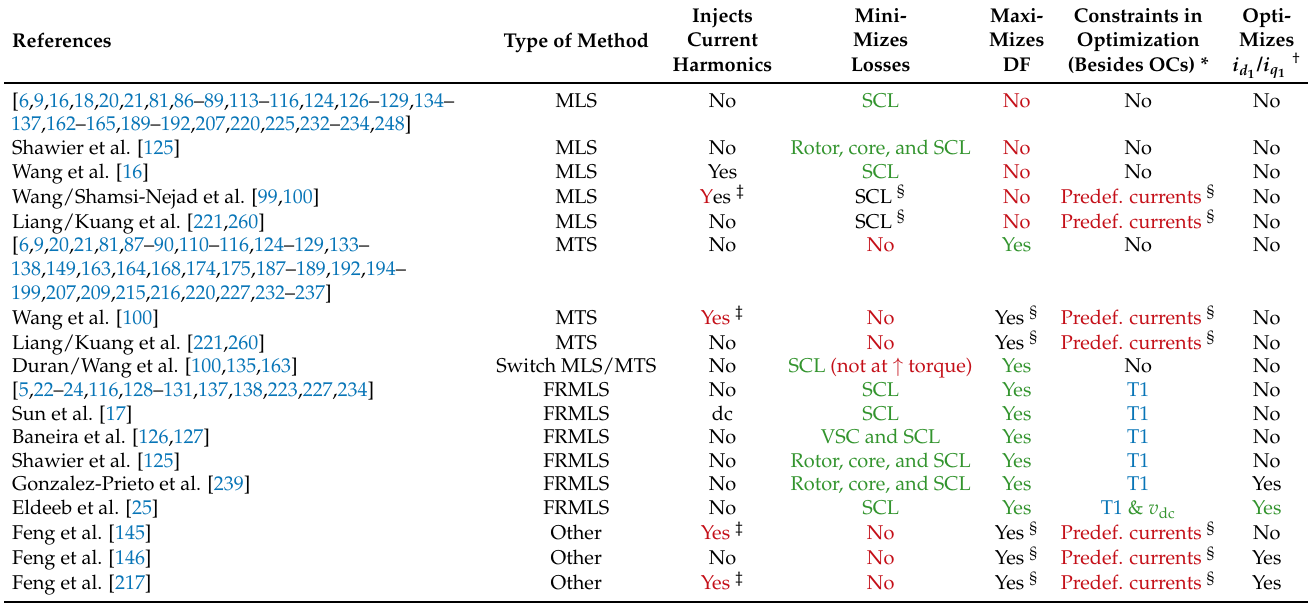
Table 12. Methods for generating current references under phase/switch OCs neglecting the effect of space harmonics on torque (Section 3.5.1) in multiphase applications in the literature. Setting x - y currents to zero [78,79,103,110,111,117,123,159,236] (equivalent to MLS [79]) while using suitable reduced-order VSD is not included. The approaches for just optimizing the i d three-phase drive, are not included